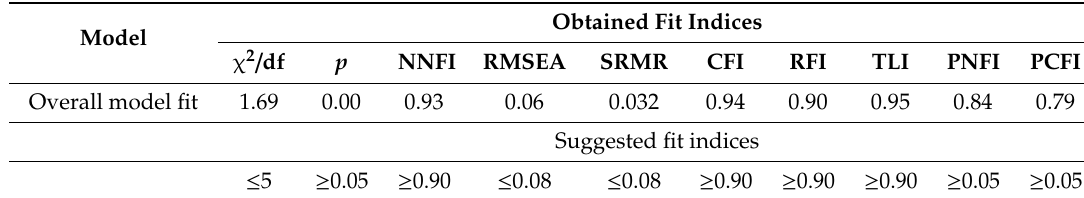
Table 1. Measurement model results for reflective